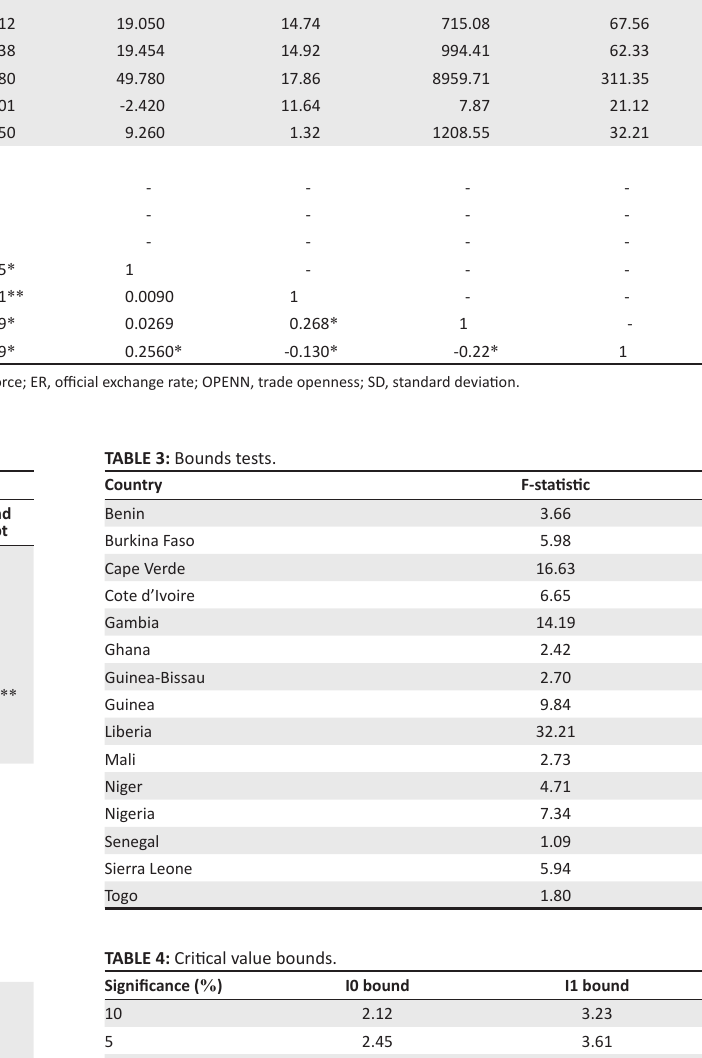
TABLE 1: Descriptive statistics and correlation matrix. Variables Panel A: Summary statistics